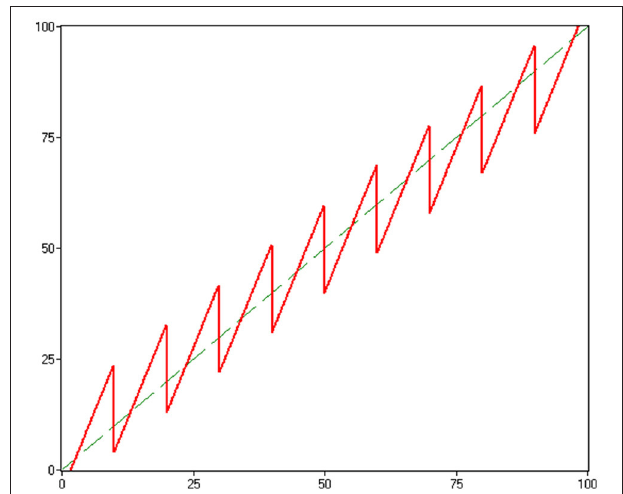
FIGURE 7 | The shape of the map if the price domain is subdivided in interval of length equal to 10. The values of the parameters are: a = 1, f = 0.1, c = 2, and F =